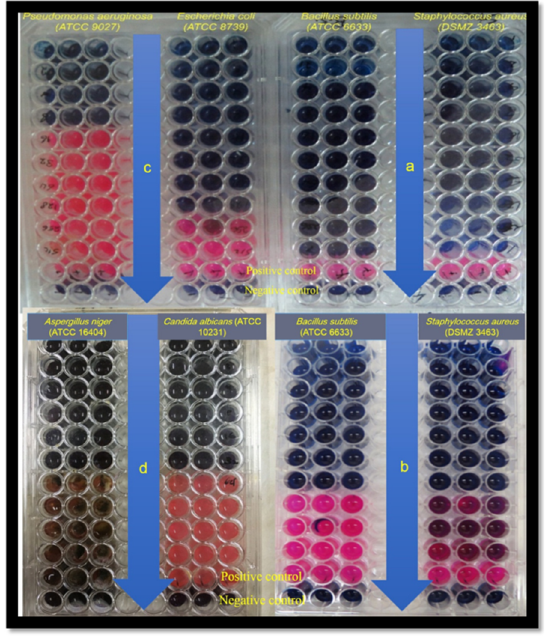
Figure 2. Minimum inhibitory (MIC) and minimum bactericidal/fungicidal (MBC/MFC) concentrations of the SCGS estimation using a two-fold micro dilution method in 96 well micro-titer plates in comparison to a positive control (inoculated with microorganism without the SCGS) and a negative control (only sterile media). The plates were visually elaborated using a resazurin as an oxidation-reduction indicator at a concentration of 0.015%. The well with no color change (blue resazurin) means negative result or no growth however the changed color (pink color) means positive result or there is bacterial growth. (a, b) Were the plates of Staphylococcus aureus (DSMZ 3463), Bacillus subtilis (ATCC 6633) with more dilution. (c) The plate of Escherichia coli (ATCC 8739), Pseudomonas aeruginosa (ATCC 9027). (d) The plate of Candida albicans (ATCC 10231) and Aspergillus niger (ATCC 16404).